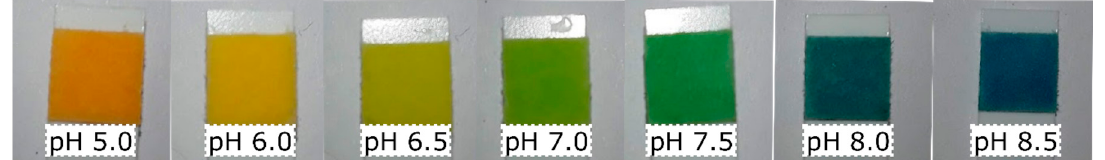
Figure 1. Exemplary images taken with the Huawei of pH strips that were used to build calibration